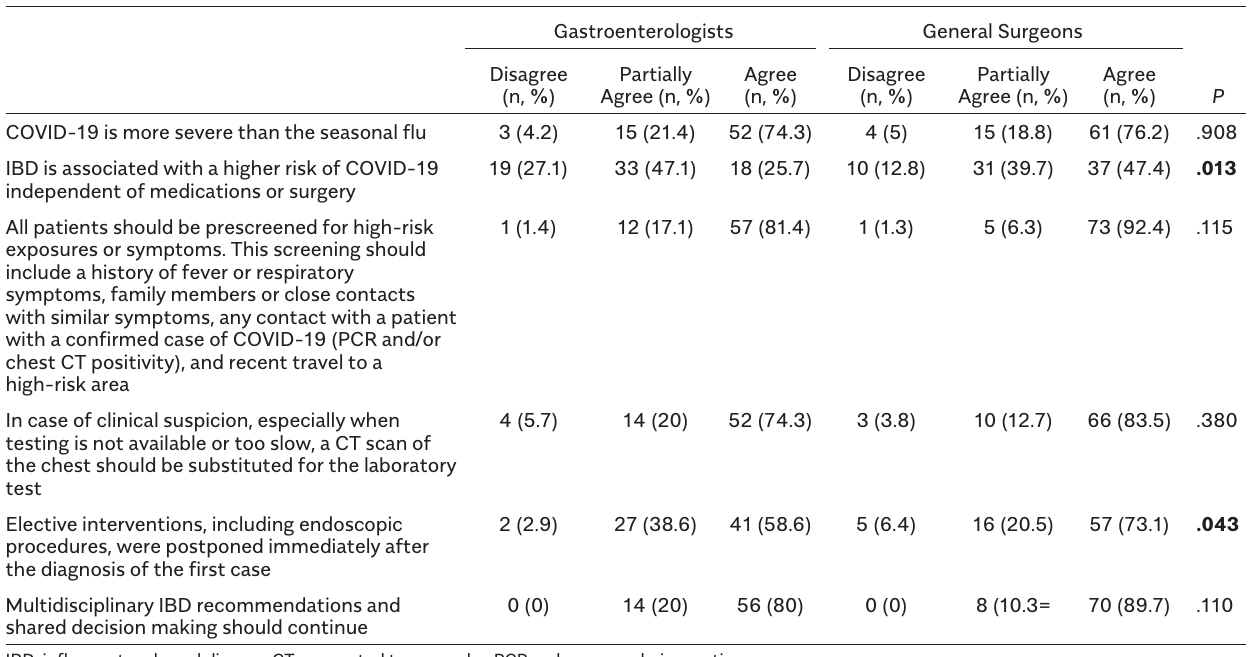
Table 1. Differences in the Perception of COVID-19 by Physicians and Surgeons Gastroenterologists General Surgeons